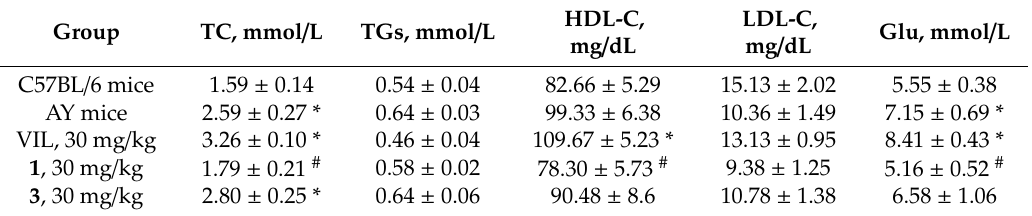
Table 5. Blood biochemical parameters in treated AY mice at the end of the experiment.